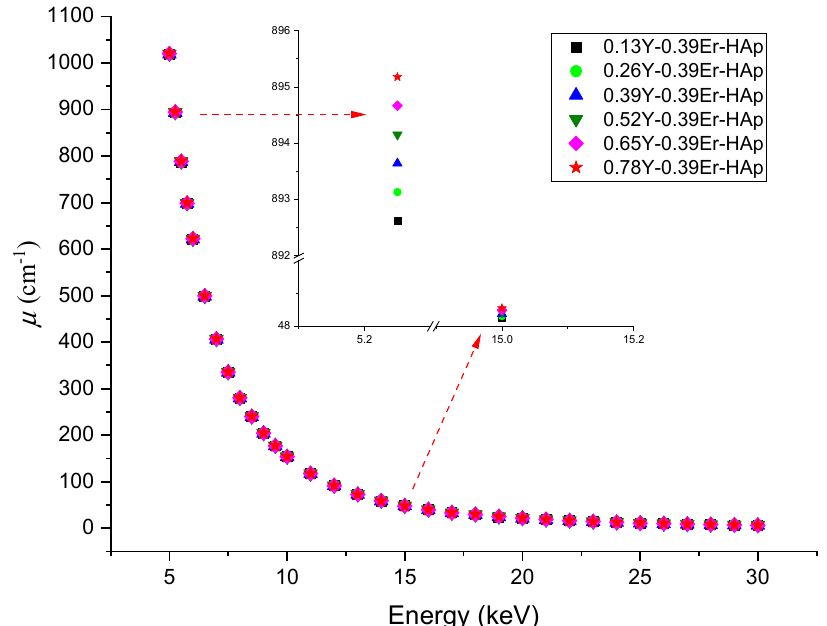
Figure 12. Energy-dependency of the linear absorption coefficient for all the samples.